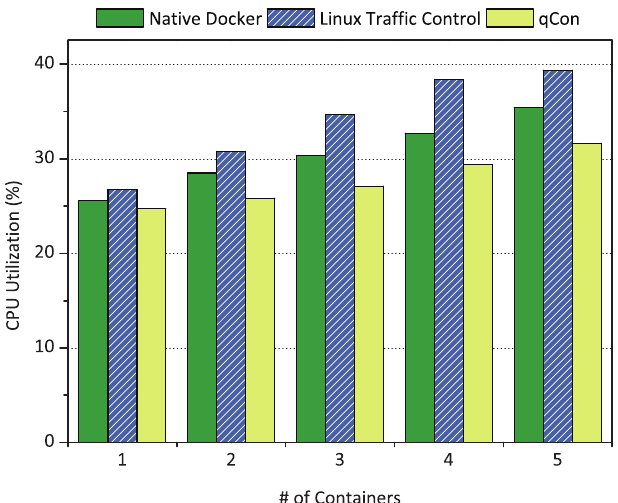
Figure 12. CPU utilization of the target board with the increase of active containers from one to